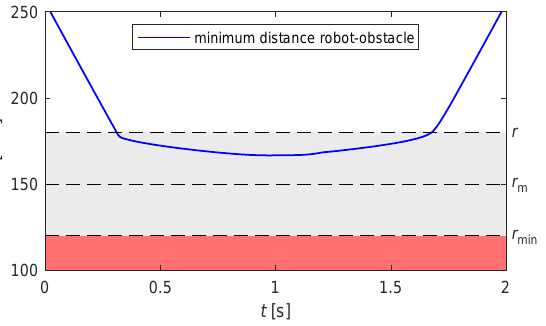
Figure 10. Example 1: minimum distance robot-obstacle for the motion shown in Figure 9.